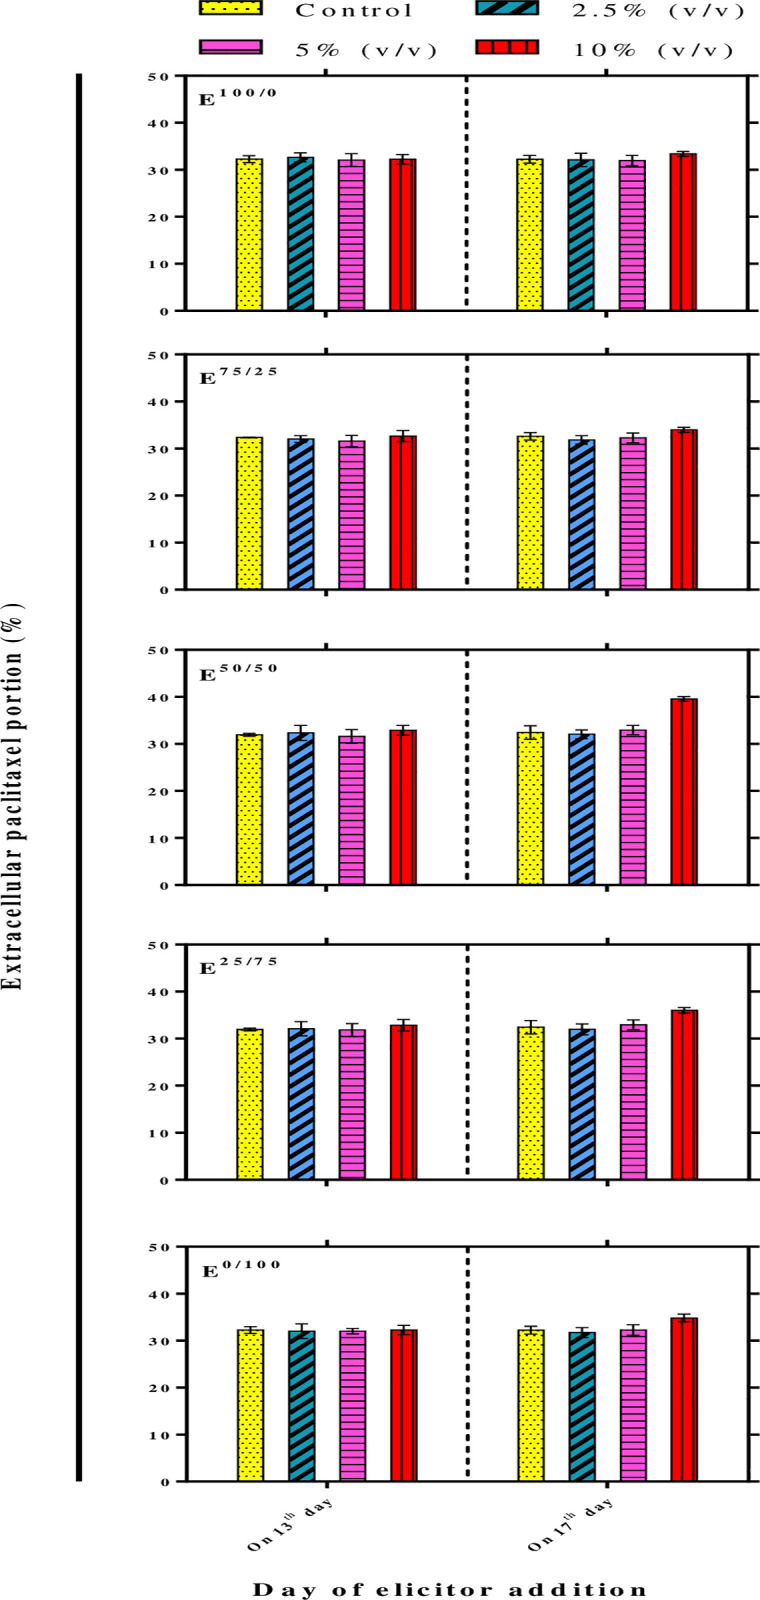
Extracellular paclitaxel portion (%) in Corylus avellana cell suspension culture exposed with 2.5, 5 and 10% (v/v) of cell extract (CE) and/or culture filtrate (CF) derived from Camarosporomyces flavigenuson on 13th and 17th days of cell culture cycle.E100/0; 100CE:0CF, E75/25; 75CE:25CF, E50/50; 50CE:50CF, E25/75; 25CE:75CF, E0/100; 0CE:100CF.